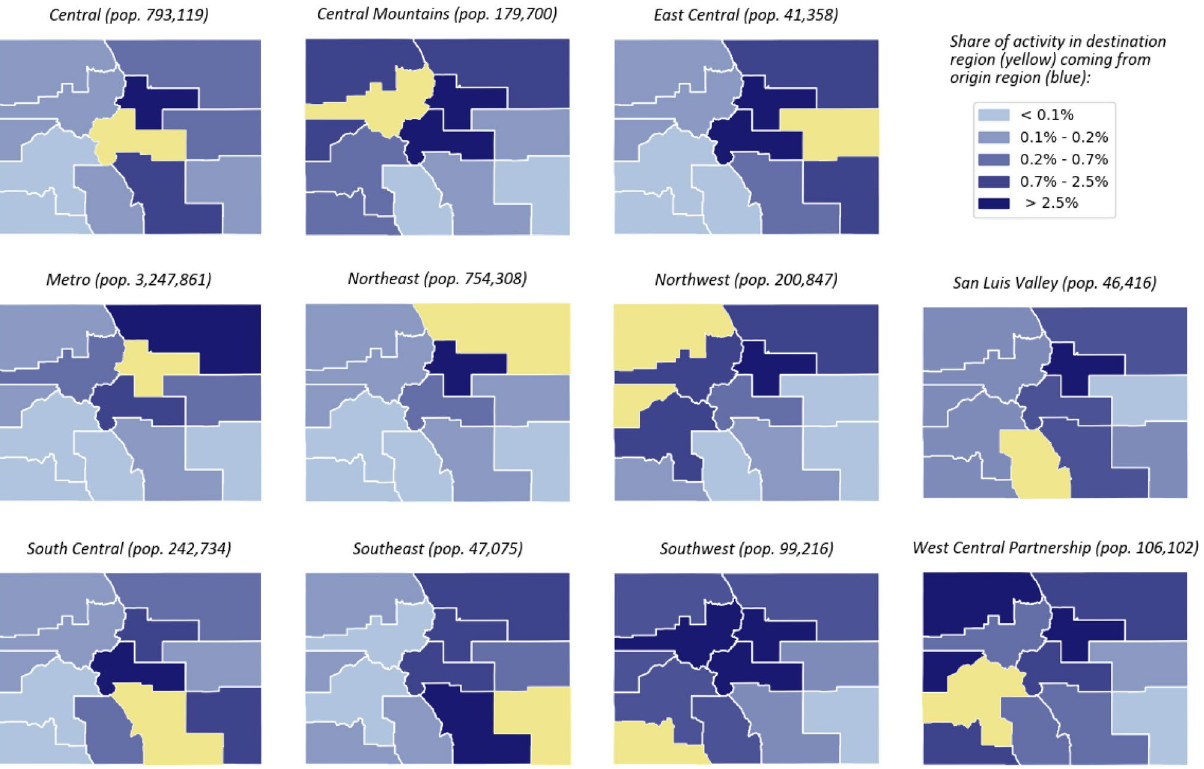
Figure 4. Regional connectivity patterns between the 11 Local Public Health Agency regions in Colorado, USA. Each panel illustrates the intensity of contact between residents of the yellow region and individuals traveling from the blue regions. Total travel volume is averaged over the time period 01/01/20–12/31/20. Data obtained from Safegraph (see Data illustrates the number of hospitalized individuals in the time-interval 03/01/21–03/01/22, together with the contact levels u i , as selected by the controller. By comparing the simulation outcomes across the various regions, our model and control methods suggest that heterogeneities among the regions can be exploited by the feedback controller, which is capable of meeting hospitalization limits in all regions by devising levels of NPIs that are region-specific. After the initial phase, uniform levels of NPIs among the regions can be used provided that all regions have homogeneous hospitalization limits. Together, our results indicate that regional heterogeneities can be used by the feedback controller, especially when the epidemic state varies widely across the regions. Note that control levels and epidemic curves varied drastically between regions throughout the pandemic, indicat- ing, among other heterogeneities, the difficulty in agreeing upon tolerable risk levels in a heterogeneous region. The value of coordination. Figure 6 considers a scenario where regions with a population of 150,000 peo- ple or less (i.e., East Central, San Luis Valley, Southeast, Southwest, and the West Central Partnership regions) drop most NPIs as of 05/01/21, returning to 80% contact levels ( u = 0.8 ). On this date, the average fraction of fully vaccinated individuals across the state is 21.29%. As illustrated by the simulation, such policy will result in a substantial violation of the hospitalization limit in all of the five regions that drop the NPIs. Not surpris- ingly, the regions that decrease NPIs on 05/01/21, are also the ones that are affected by the highest number of hospitalizations, with peaks of over 140 hospitalizations/day per 100 K inhabitants around 07/01/21. Interest- ingly, our results suggest that in this case three highly-populated regions (Central Mountains, Northwest, and South Central) are required to decrease the fraction of contact-relevant interactions to below 20% in order to not exceed the hospitalization limit of 8 individuals/day per 100 K inhabitants. This suggests that high-population regions are at high risk of outbreaks as a result of low levels of control in rural regions. Note that without increas- ing control in, for instance, the Northwest region, in response to low control levels in surrounding rural areas, the Northwest region would be at risk of large increases in hospitalizations. Together, our results indicate that regional heterogeneities can be exploited by the feedback controller to alleviate the necessary severity of NPIs to stay below hospitalization limits in interconnected regions, however, uncoordinated changes of NPIs in some of the regions will in general impact the level of NPIs imposed in all the remaining regions. We conclude by noting that, although our models are fitted to hospitalization data from the state of Colorado, and the simulations in Figs. 5 and 6 are performed for this case study, the proposed control framework and feed- back control law are applicable to any geographical region and can be implemented at a different geographical granularity.